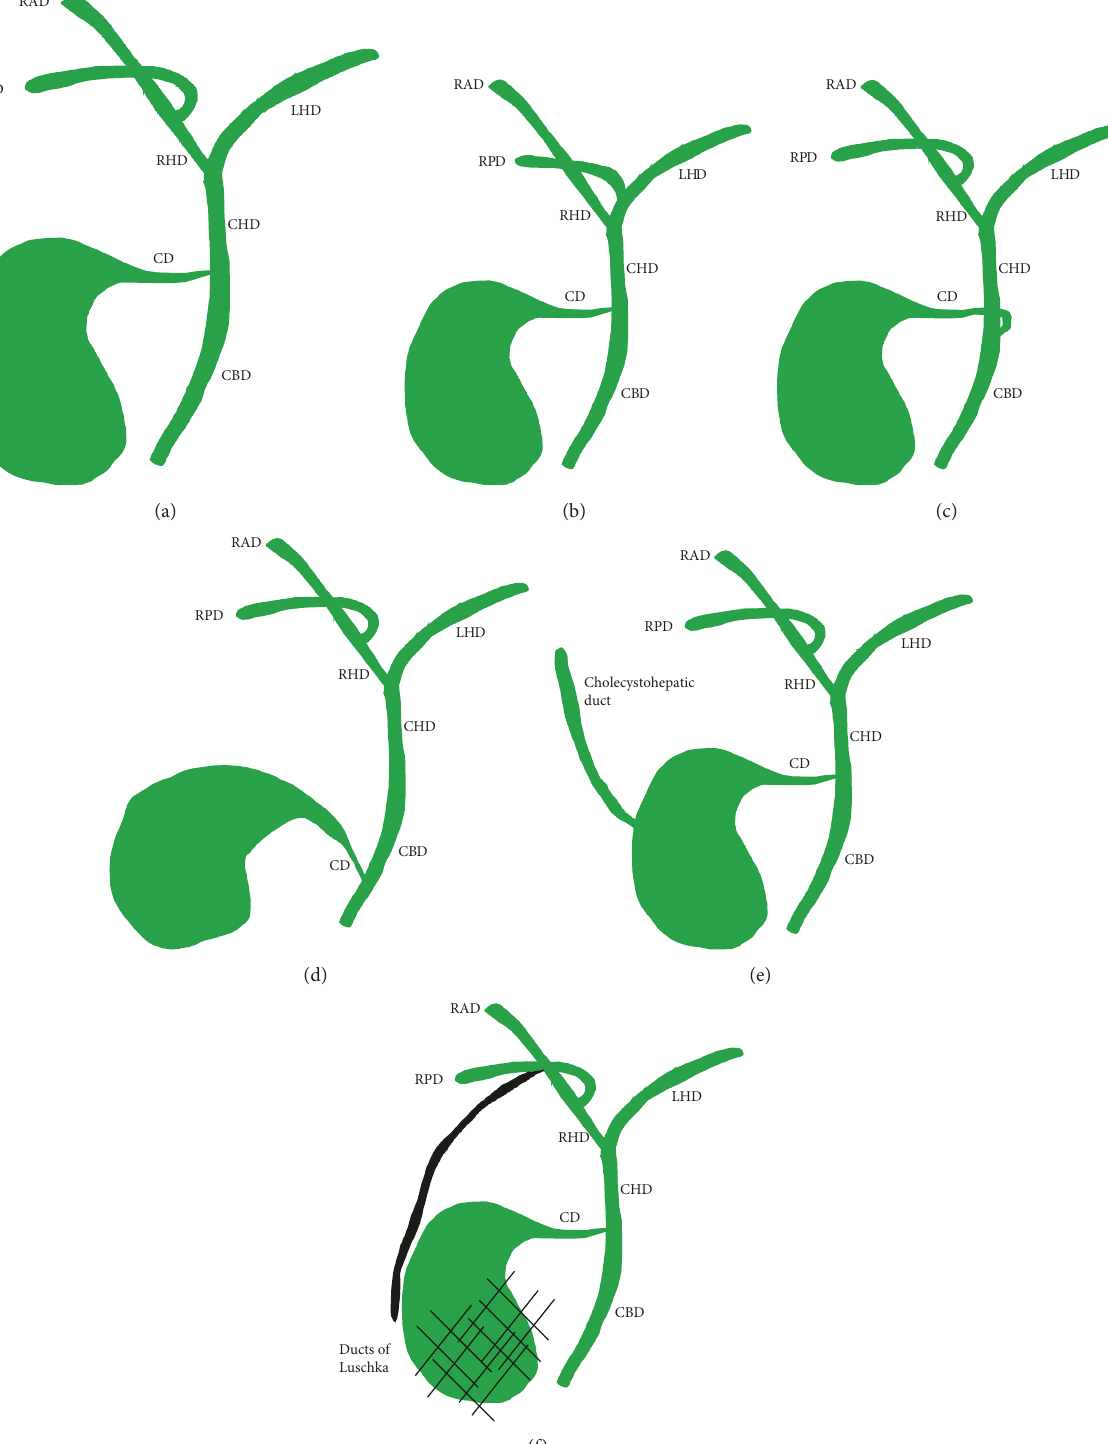
Figure 4: Conventional biliary anatomy and anatomic variants. (a) Conventional biliary anatomy. (b) Aberrant RPD inserting into the left hepatic duct (LHD). (c) Medial insertion of the CD. (d) Low insertion of the CD. (e) Cholecystohepatic duct. (f) Ducts of Luschka (depicted in